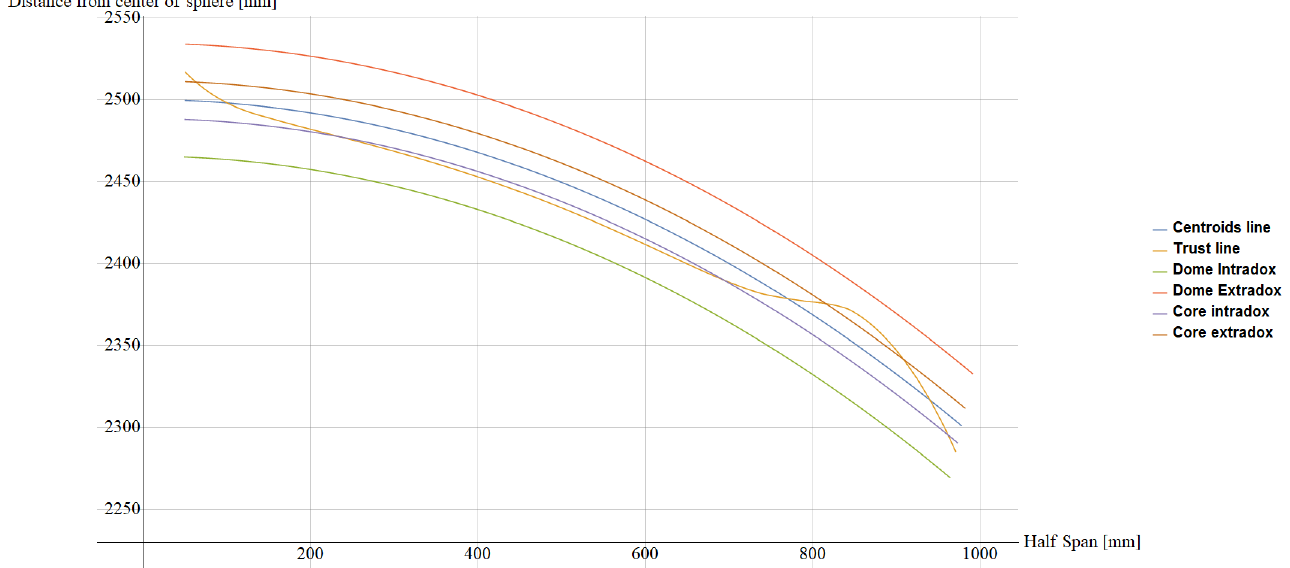
Figure 8. Thrust line along with meridian and